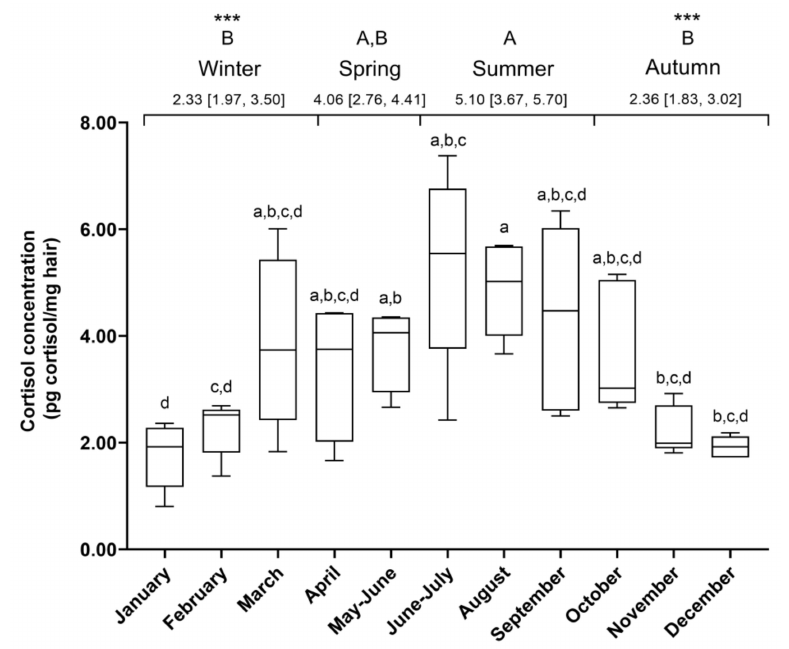
Figure 2. Fluctuation of hair cortisol concentrations over a year. Representation of hair cortisol concentrations (HCCs) (pg cortisol / mg hair) in horses (N = 5, n = 53) during a year. Di ff erent lowercase letters represent significant di ff erences between months. Di ff erent uppercase letters represent significant di ff erences between seasons (*** p < 0.001). Median (25% percentile, 75% percentile). N = number of horses per group; n = number of determinations of